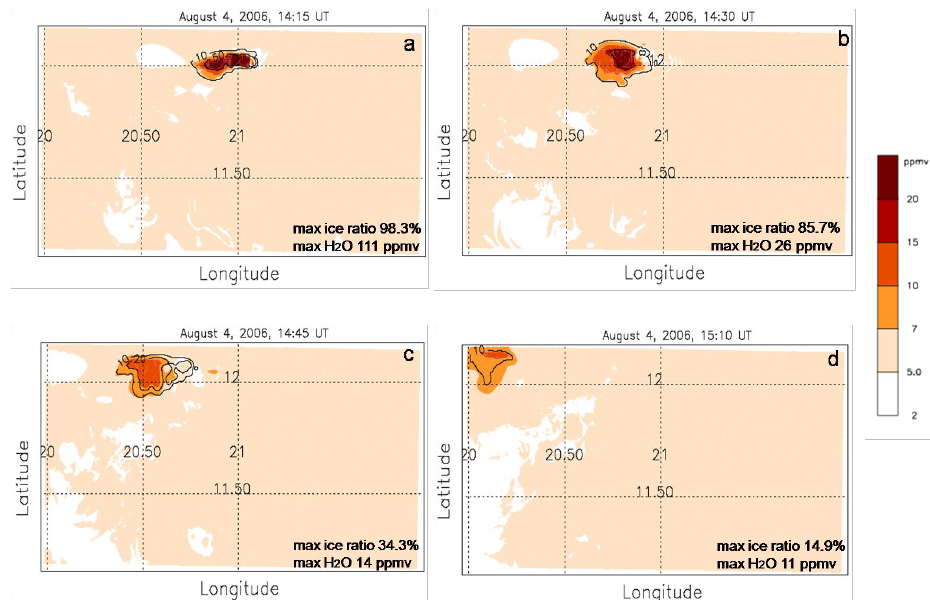
Fig. 16. Total water at the 390K isentropic level in the BRAMS Grid 3 domain at 14:15UT (a) , 14:30UT (b) , 14:45UT (c) and 15:10UT (d) for the Chad case simulation. Also shown are contours of ratio (%) of ice with respect to total water (black solid lines): (a) and (b) 10% and 50%, (c) 10% and 20%, and (d) 10%. The maximum total water mixing ratios as well as the maximum ratio (%) of ice with respect to total water are reported in each panel. The same colour scale applies to each